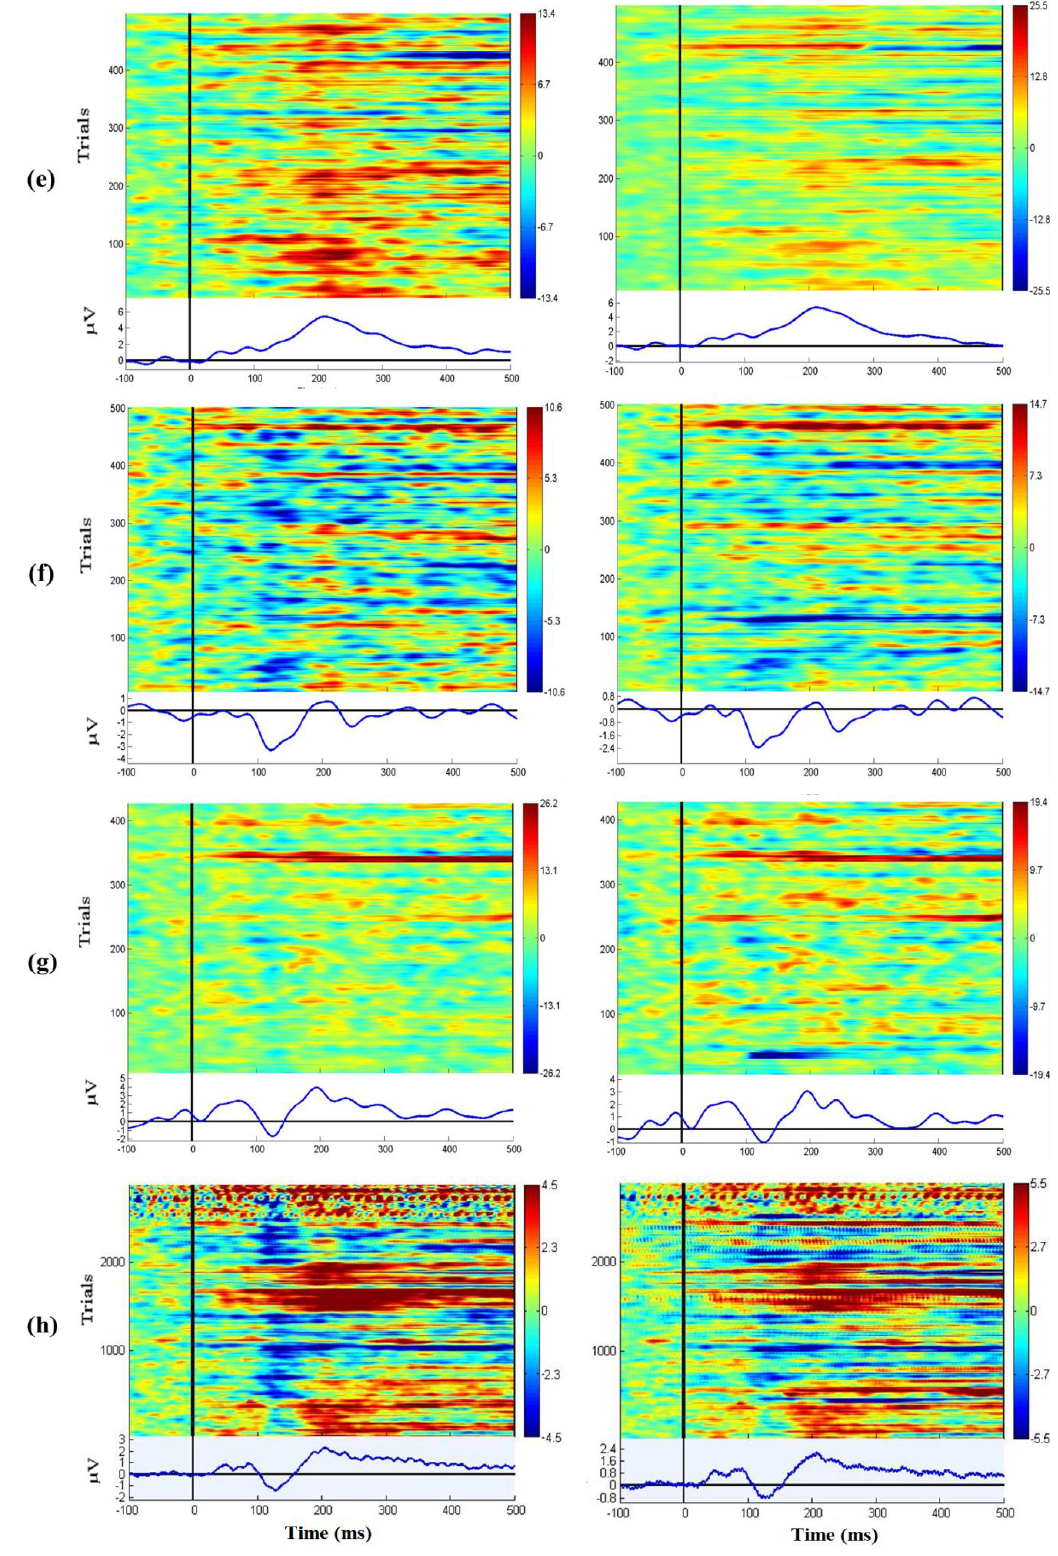
Figure 11. ( a – g ) The P200 phenomena were presented in the ERPs for both wet and dry channels for each subject; ( h ) shows the grand mean P200 components were detected by the subjects’ EEG data.